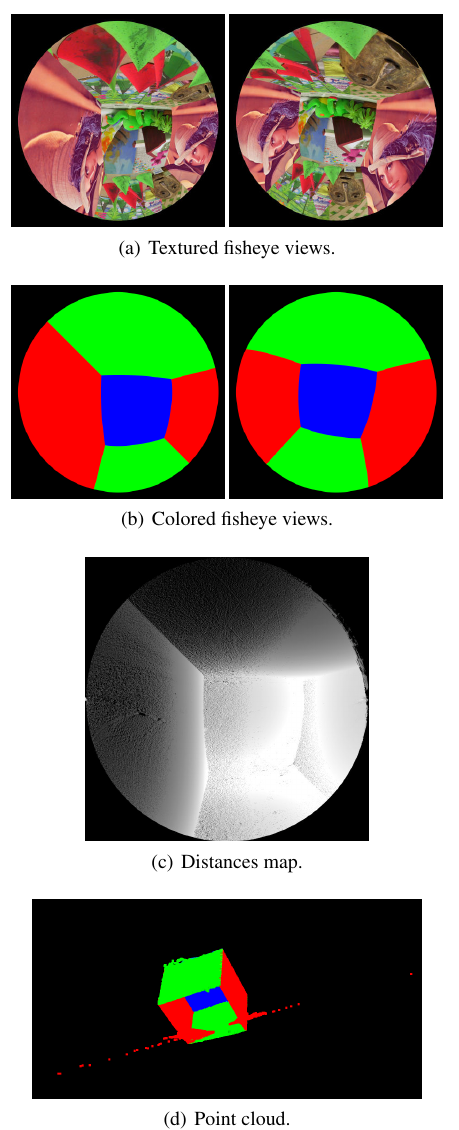
Figure 7: Fisheye images inside the cube for evaluation. 3D re- construction of the cube. Distances in distances map are shown for a limit of 5 units (white). Dark points in distance maps are non-matched points. They are numerous because of the large dif- ference of the area taken by the faces from an image to the other one. The cube’s point cloud has not been filtered.